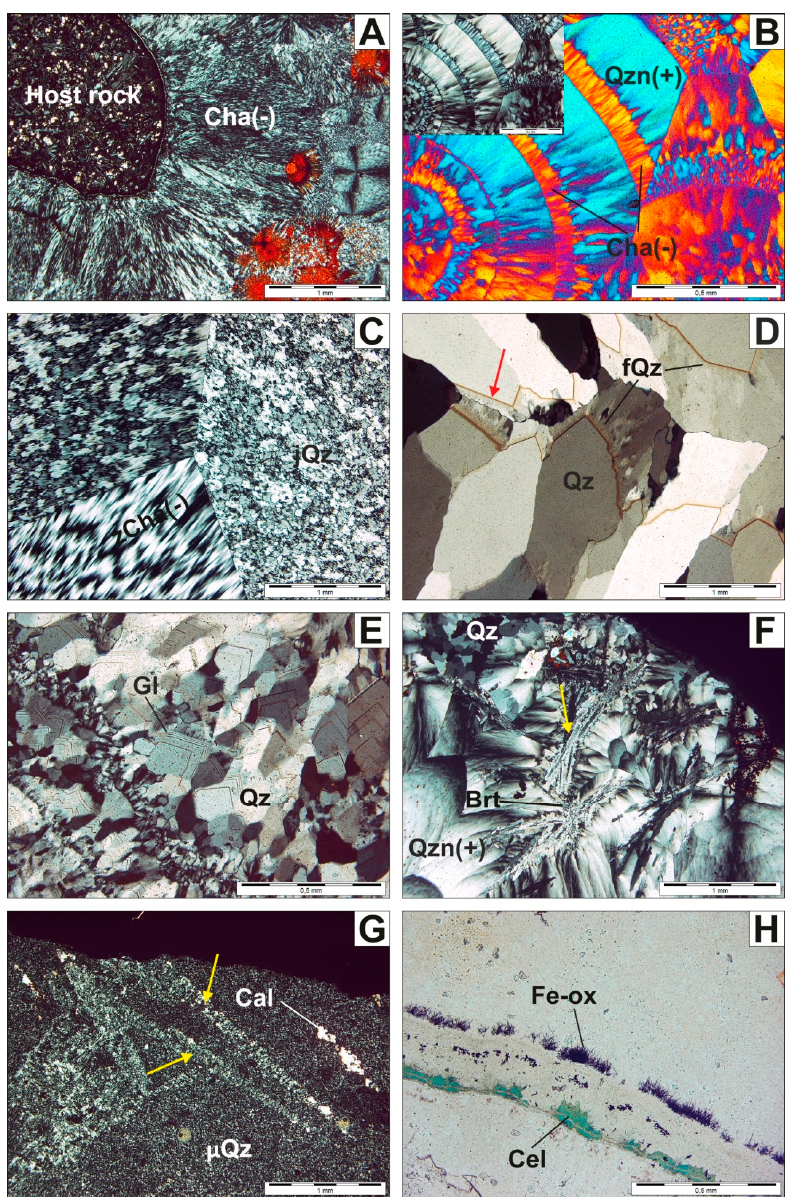
Figure 3. Photomicrographs of agate samples. ( A ) Bundle-like accumulation of chalcedonic spherules and Fe-oxides at the contact with host rocks comprising tabular plagioclases and anhedral pyroxenes—PX. ( B ) Length-fast chalcedony interlayered with length-slow chalcedony (quartzine)—NX with a gypsum plate inserted from the lower left. ( C ) Polygonal-shaped crystals of zebraic chalcedony; note the vanishing chalcedony fibrous texture at the expense of jigsaw puzzle quartz (with interpenetrating grain boundaries)—PX. ( D ) Internal part of the geode occupied by euhedral prismatic quartz crystals with feathery / spilintery appearance; red arrow points to the minute pigment of oxides developed at the edges of quartz crystals—PX. ( E ) Discrete growth lines (so-called Bambauer quartz) developed within quartz crystals. ( F , G ) Plate-like form of silica phases associated with minor barite (almost indistinguishable from quartz due to low birefringence) and calcite. ( H ) Celadonite accompanied by needle-like crystals of Fe-oxides in the external areas of the agate. Abbreviations: Cha(-): length-fast chalcedony; Qzn( + ): length-slow chalcedony (quartzine); zCh(-): zebrai´c chalcedony; fQz: feathery quartz (with undulose extinction); Gl: growth lines; jQz: mosaic quartz (with interpenetrating grain boundaries); Qz: megaquartz ( > 20 µ m in size); µ Qz: microcrystalline quartz ( < 20 µ m in size); Cel: celadonite; Cal: calcite; Fe-ox: iron oxides /